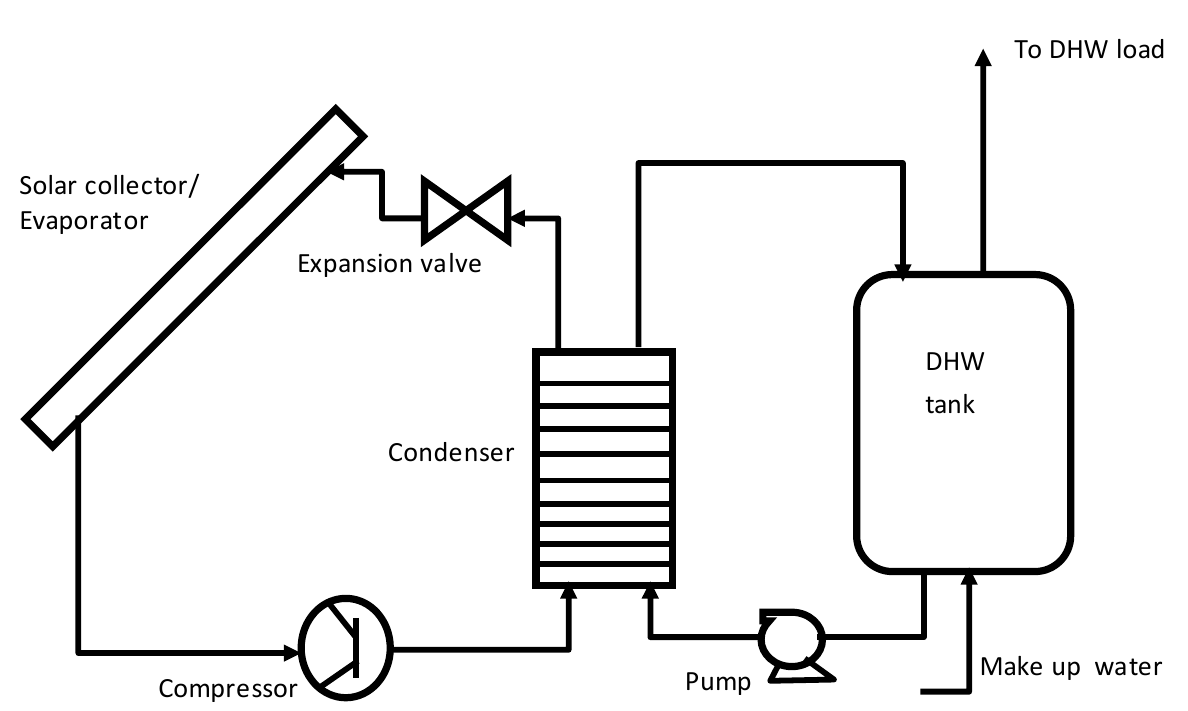
Figure 1. Series connection—IX-SAHP.